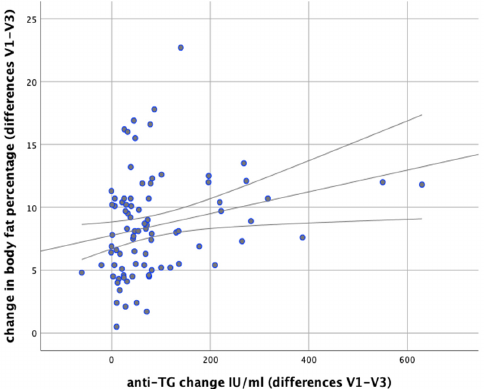
Figure 12. Correlations between changes in body fat content and changes in serum anti-TG levels in the women studied (between initial visit V1 and final visit V3). Nutrients 2021 , 13 , x FOR PEER REVIEW There were no significant correlations observed between changes in anti-TPO levels and changes in body weight ( r = 0.148; p =0.177). There were no significant correlations revealed between changes in body fat content and anti-TPO levels either ( r = 0.156; p =0.154), as shown in Figure 13 However, a significant positive correlation was found be- tween changes in BMI and changes in anti-TPO levels ( r = 0.246; p =0.023), as shown in Figure 14.